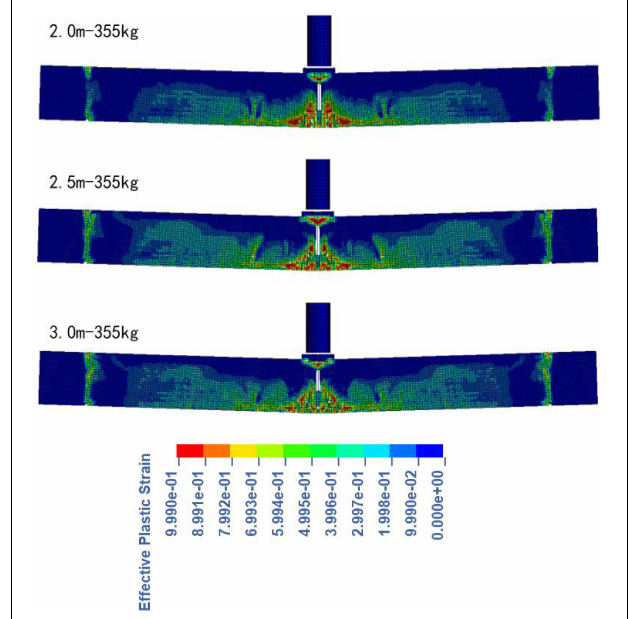
FIGURE 10 | Ordinary beam failure morphology at different impact